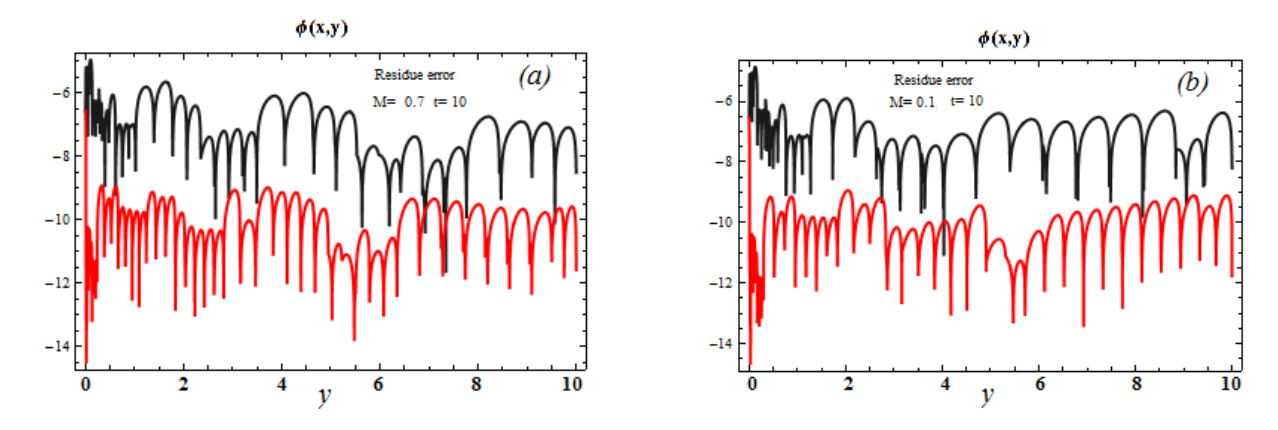
Figure 7. Residue error for concentration for physical parameters ( a ) M = 0.7 and ( b ) M = 0.1.